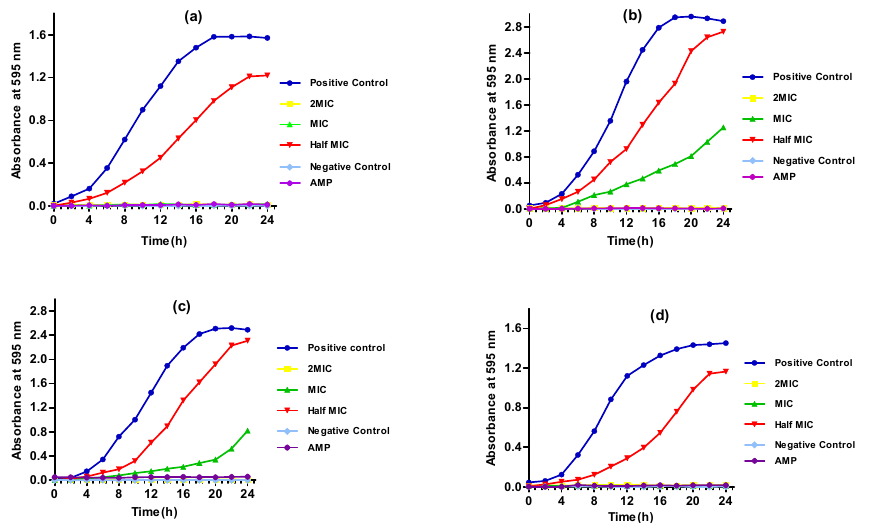
Figure 2. Growth curve at various concentrations of compound PS9 ( a ) E. coli ( b ) E. faecalis ( c ) K. pneumoniae and ( d ) P. aeruginosa. ( c ) K. pneumoniae and ( d ) P. aeruginosa